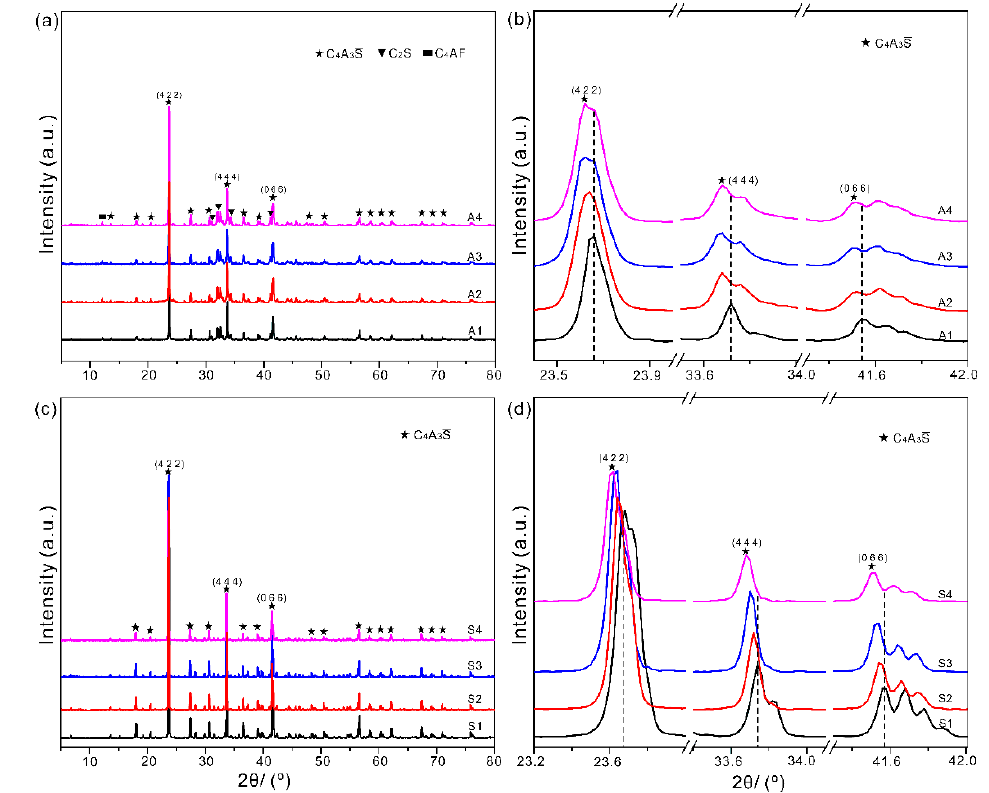
Figure 4. The full ranged and enlarged XRD patterns of SAC clinker ( a ), ( b ) and the single mineral C 4 A 3 S(cid:3364) ( c ), ( d ). The Miller indices of three main peaks of C 4 A 3 S(cid:3364) are also presented in each panel.